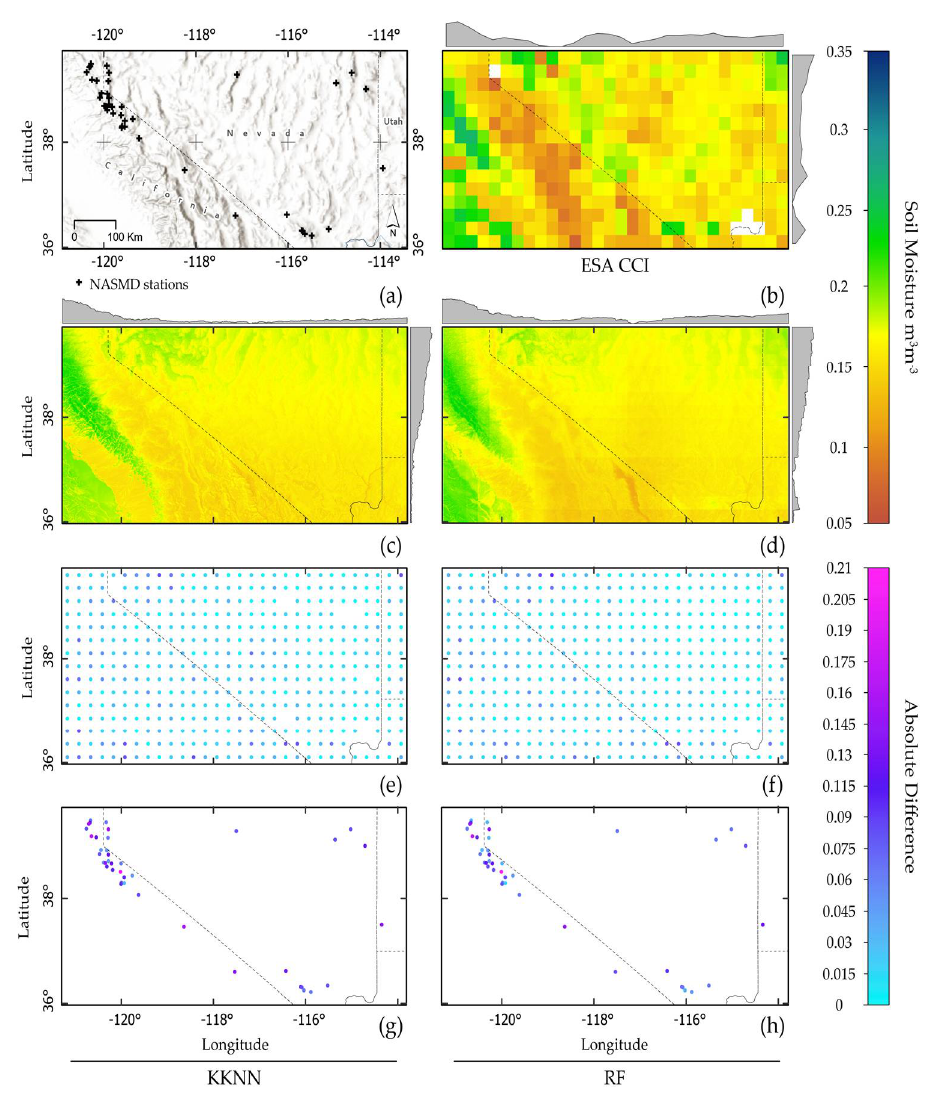
Figure 9. ( a ) West ROI and distribution of NASMD stations throughout 2010; ( b ) mean soil moisture values of 12 monthly and 52 weekly layers based on the reference ESA-CCI values at 0.25 degrees of spatial resolution; ( c , d ) mean values of 1 km soil moisture predictions with KKNN and RF; ( e , f ) spatial distribution of mean absolute differences between ESA-CCI sampling points at 0.25 degrees and their spatially correspondent predicted soil moisture values in all layers at 1 km with KKNN and RF; ( g , h ) spatial distribution of mean absolute differences between all monthly and weekly soil moisture values from NASMD and predicted values at 1 km using the two methods tested.